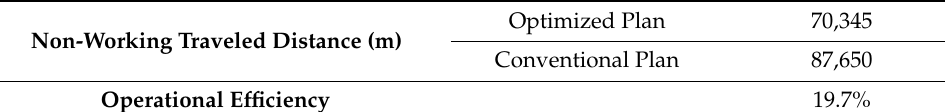
Table 3. Comparison between conventional and optimized plan.